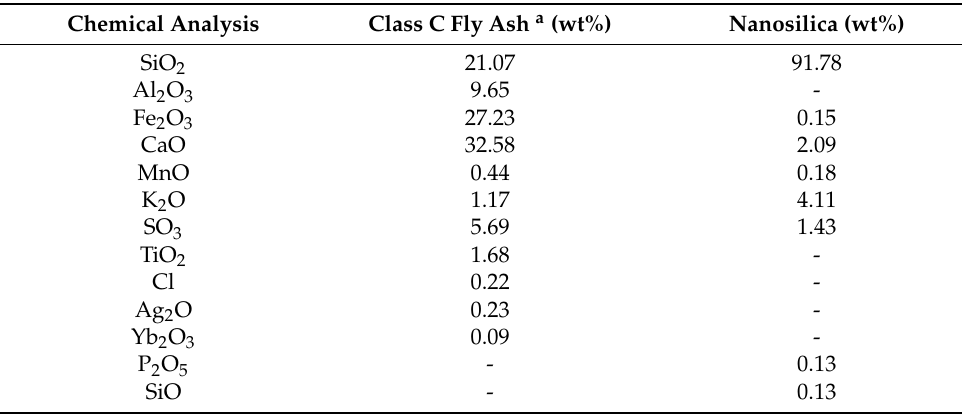
Figure 1. The morphology of raw materials: ( a ) fly ash and ( b ) nanosilica. Table 1. Chemical composition of fly ash and